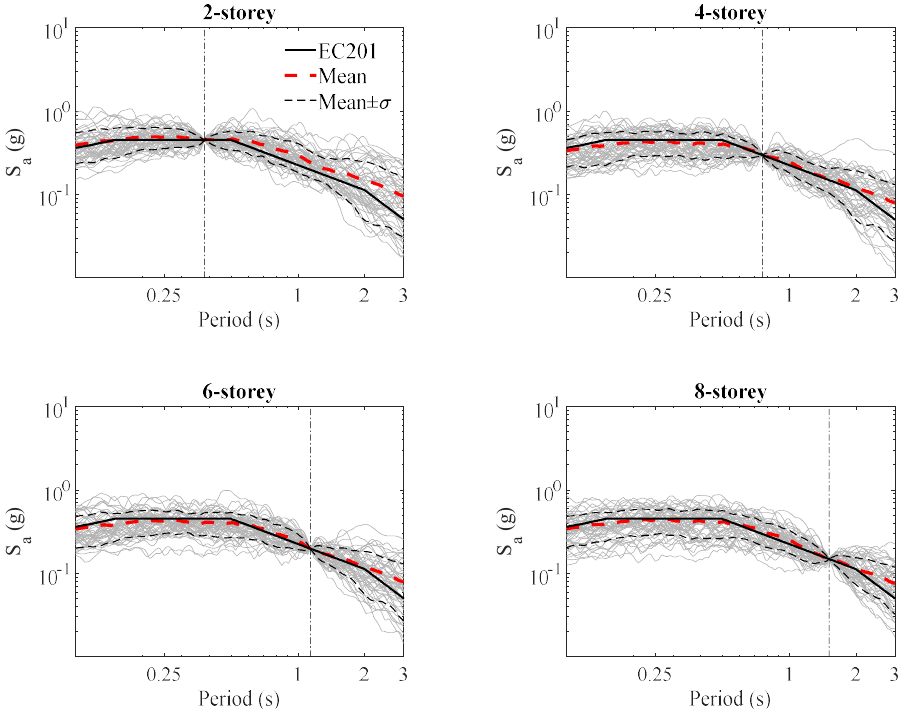
Figure 10. Scaled response spectra for the fifty ground motions with their mean response spectrum and the target elastic response spectrum for Zone 3 of the Egyptian territory according to the Egyptian code for loads EC201 (Type 2 design response spectrum and Soil B) at four different periods.